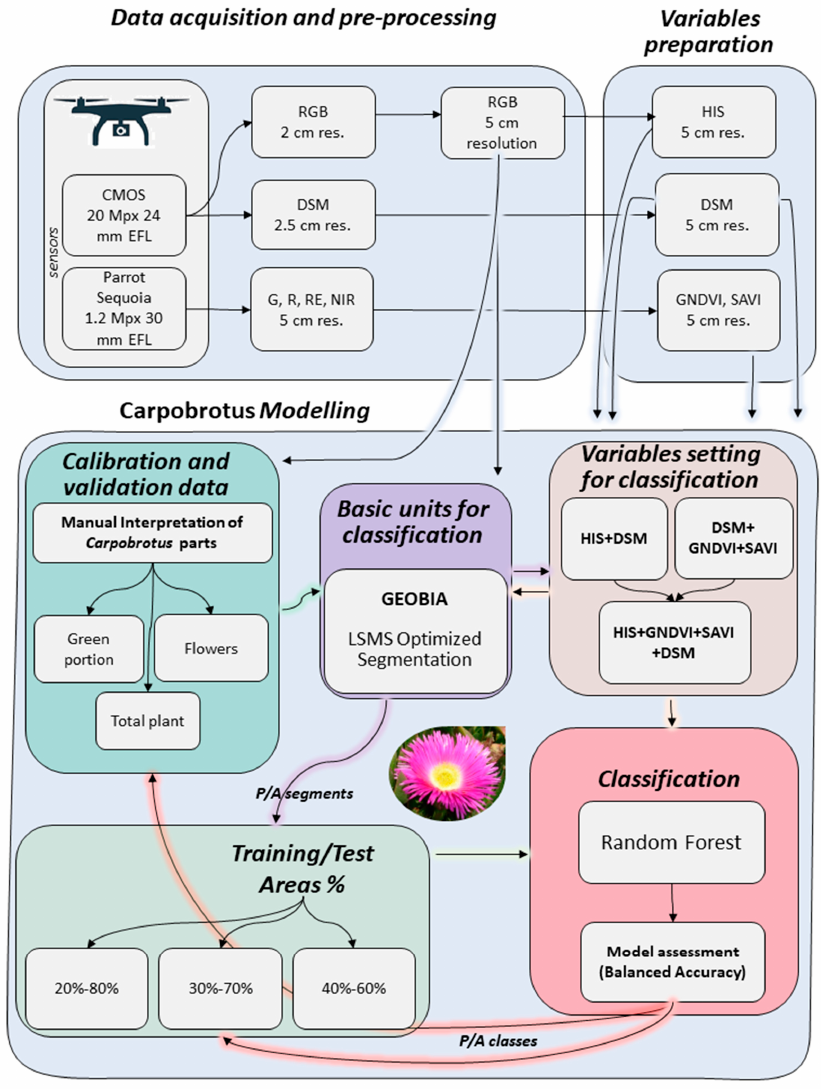
Figure 3. Simplified outline of the semi-automatic classification approach based on OBIA followed by machine learning classification adopted in this study. For details, see Section 2.